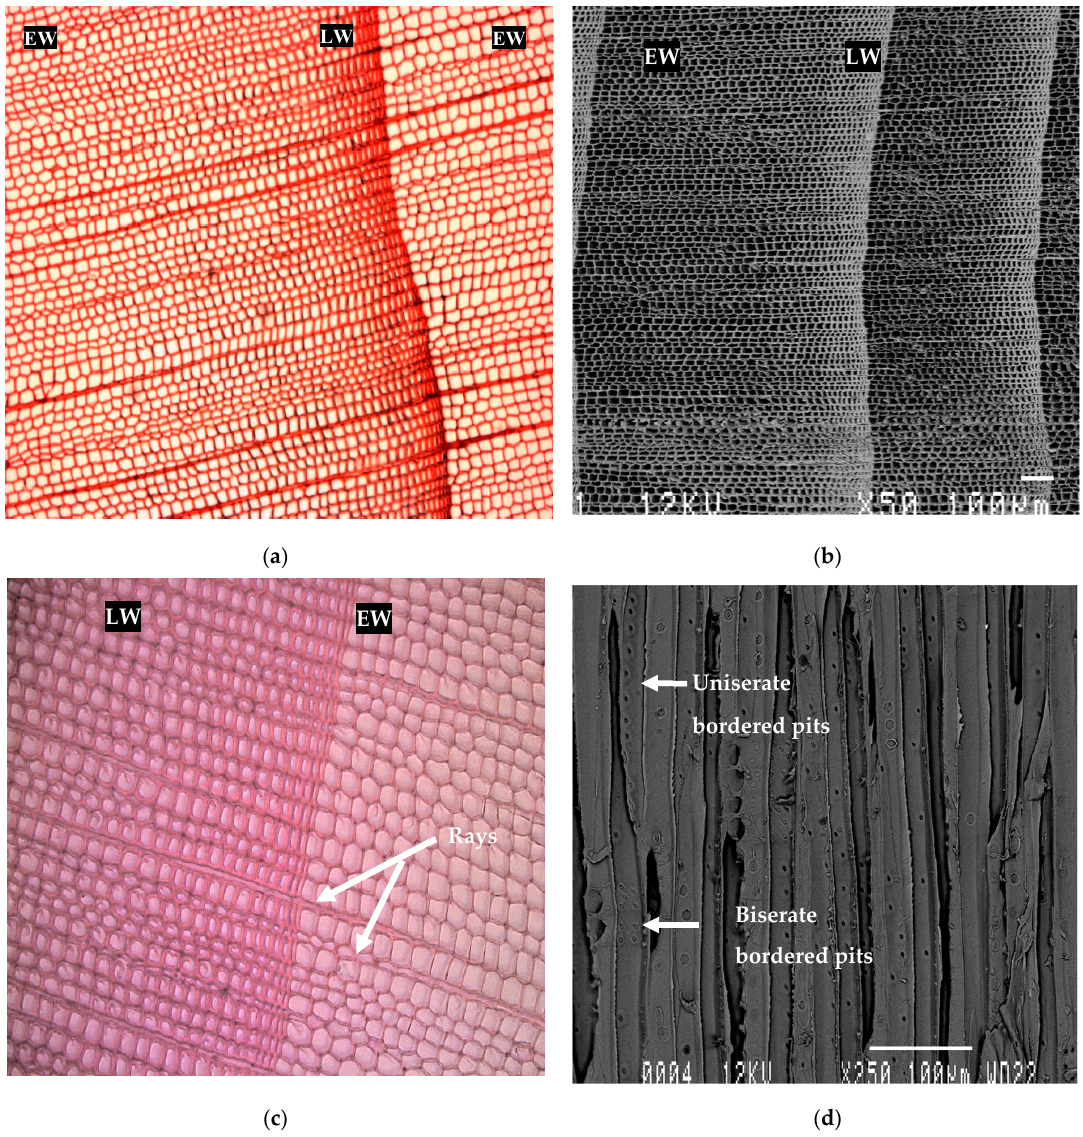
Figure 2. Cell structure of T. occidentalis wood: ( a , b ) transverse sections showing the gradual transition from early- to latewood ( × 10 (optical microscope) and × 50 (SEM), respectively); ( c ) transverse section (optical microscope) showing uniseriate xylem rays ( × 20) and ( d ) radial section (SEM) showing uniseriate and biseriate bordered pits in earlywood tracheids ( × 250). EW: earlywood, LW: latewood.